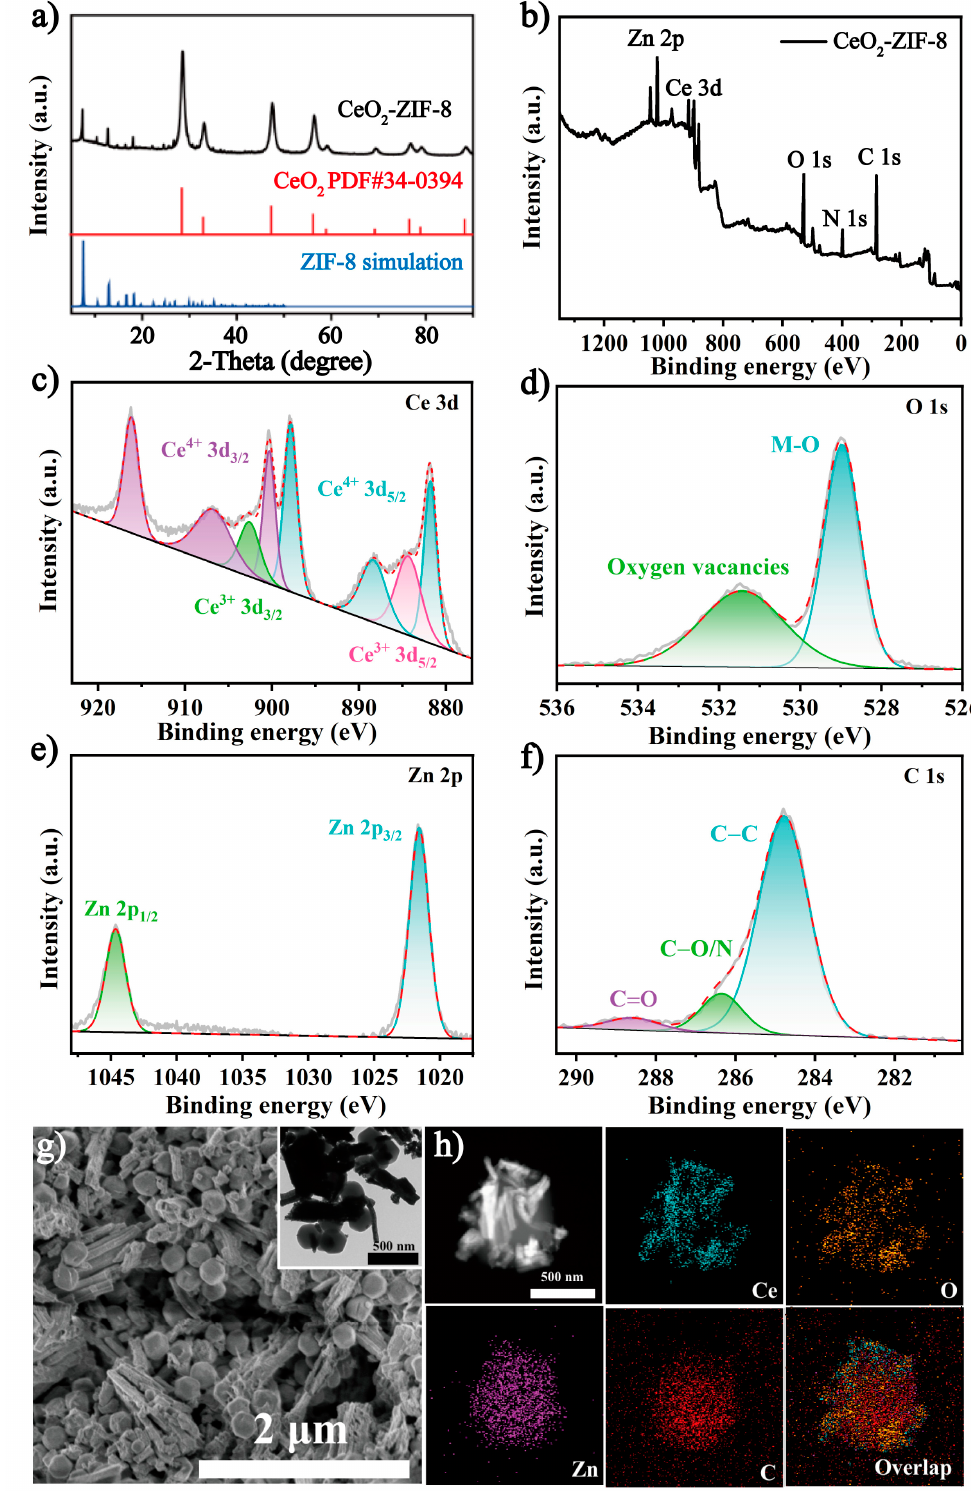
Figure 1. ( a ) XRD pattern and ( b ) full XPS spectrum of CeO 2 -ZIF-8. ( c – f ) constitutional element XPS spectra of Ce 3d, O 1s, Zn 2p, and C 1s. ( g ) SEM image and TEM image (inset) of CeO 2 -ZIF-8. ( h ) Mapping images of CeO 2 -ZIF-8.